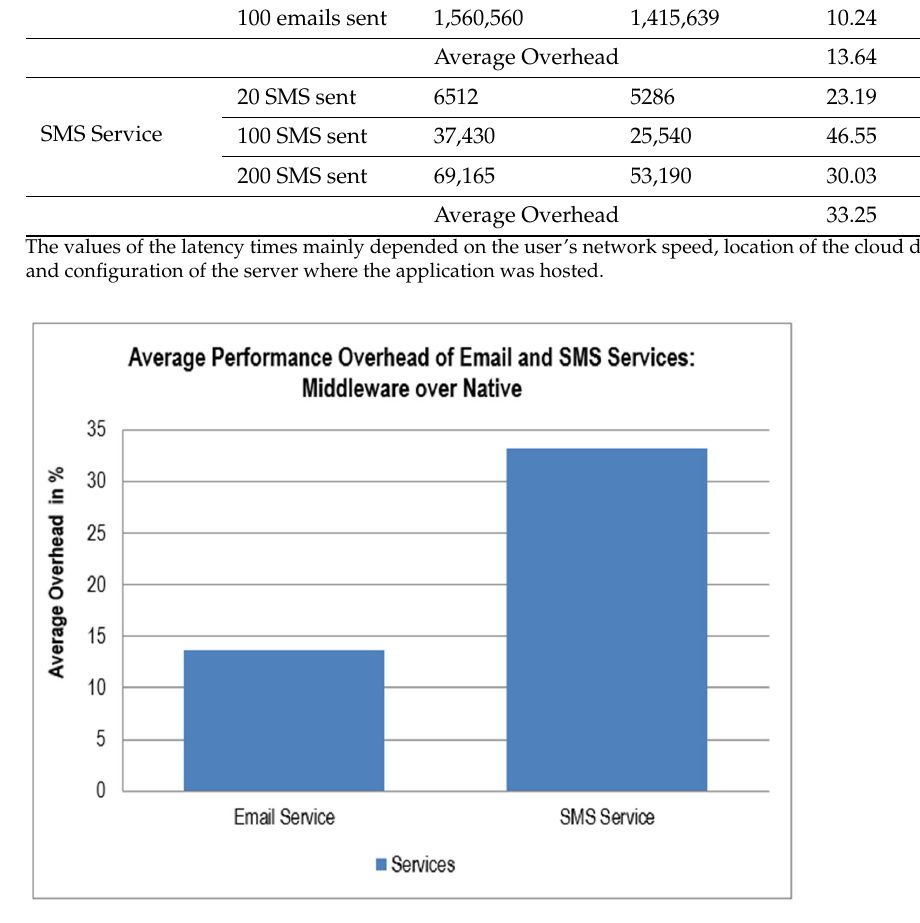
Figure 4. Performance overheads of email service and SMS service.